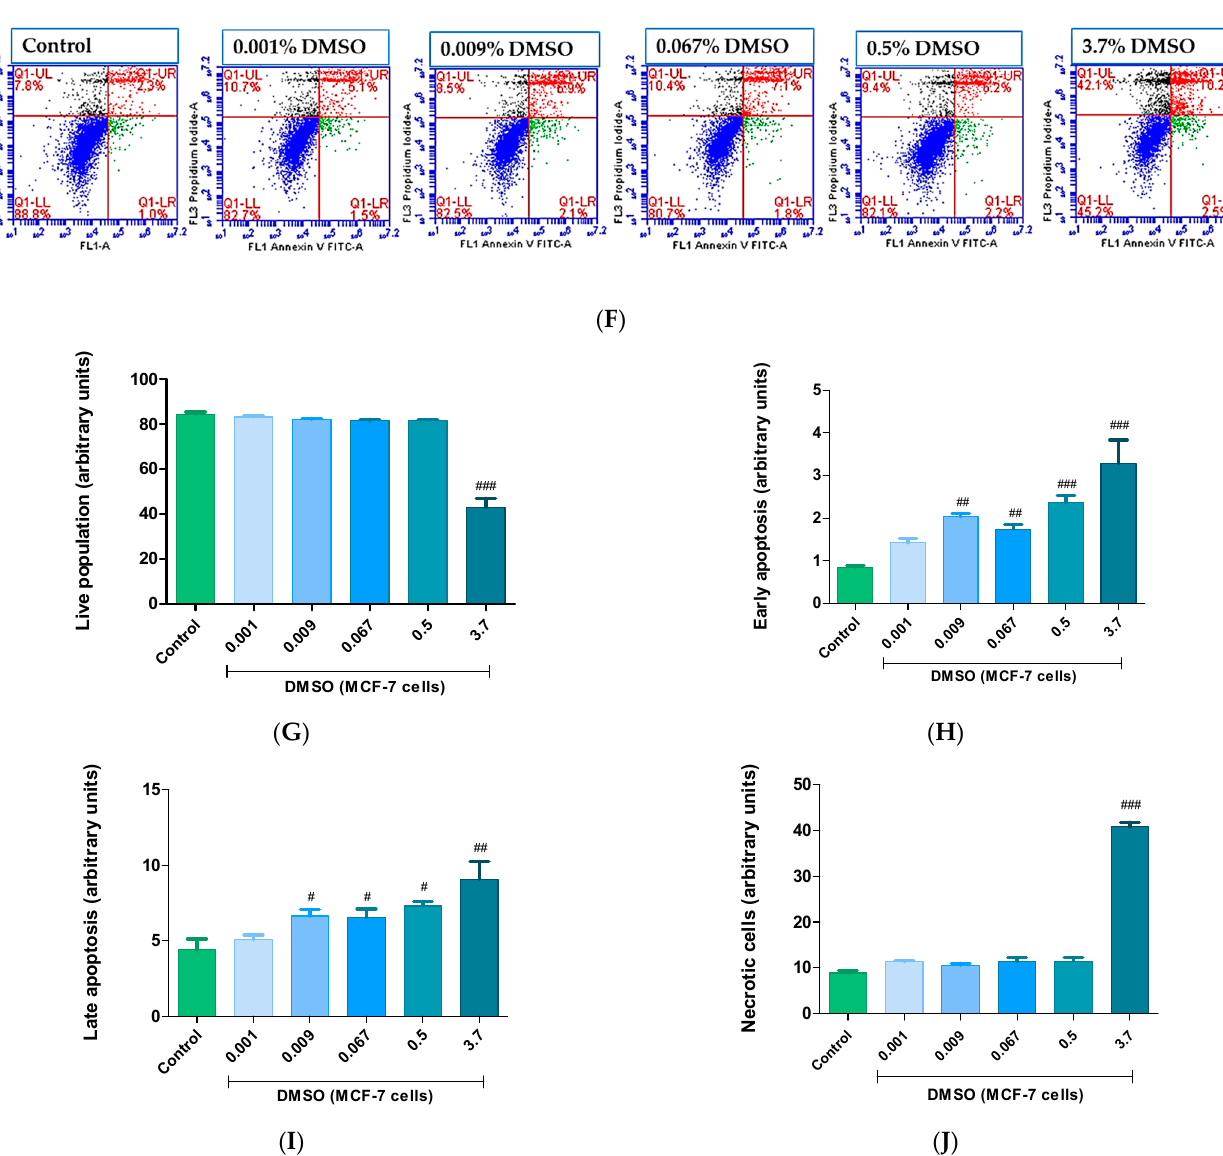
Figure 5. Dimethyl sulfoxide (DMSO)-induced apoptosis in the H9c2 cardiomyoblasts and MCF-7 breast cancer cells . ( A ) Flow cytometry scatter plot, ( B ) live population, ( C ) early apoptotic, ( D ) late apoptotic and ( E ) necrotic H9c2 cells. ( F) Flow cytometry scatter plot, ( G ) live population, ( H ) early apoptotic, ( I ) late apoptotic and ( J ) necrotic MCF-7 cells . Cells were treated every second day for 6 days with varying DMSO concentrations (0.001, 0.009, 0.067, 0.5, and 3.7%). Data are presented as the mean ± SEM of 3 biological experiments with 3 technical repeats ( n = 3). Significance is indicated as # p < 0.01, ## p < 0.01, and ### p < 0.001 versus the control.